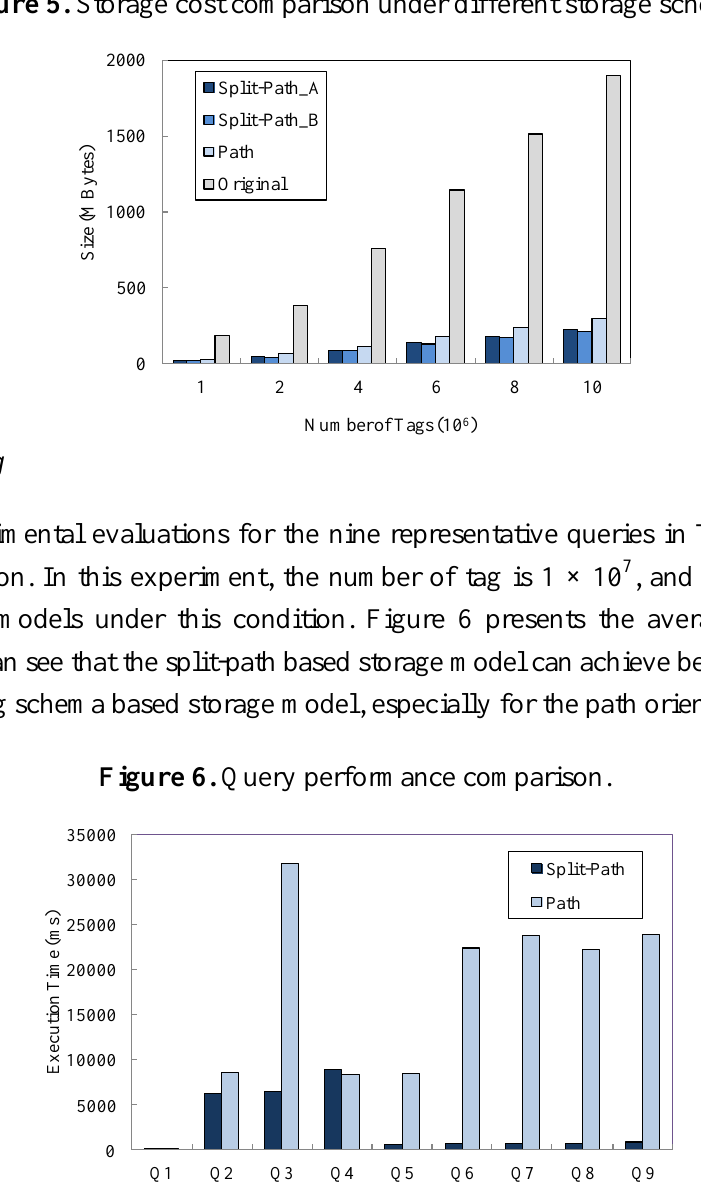
Figure 5. Storage cost comparison under different storage schema.